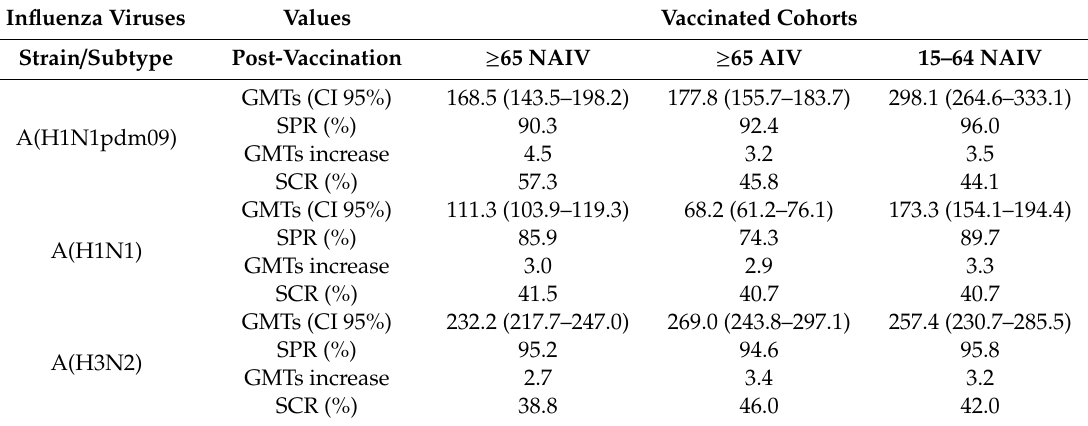
Table 2. Post-vaccination status and effect of each cohort against each influenza A strain / subtype in terms of the GMTs (geometric mean titers), SPR (seroprotection rate), GMT increase (post-GMTs / pre-GMTs) and SCR (4-fold induction).